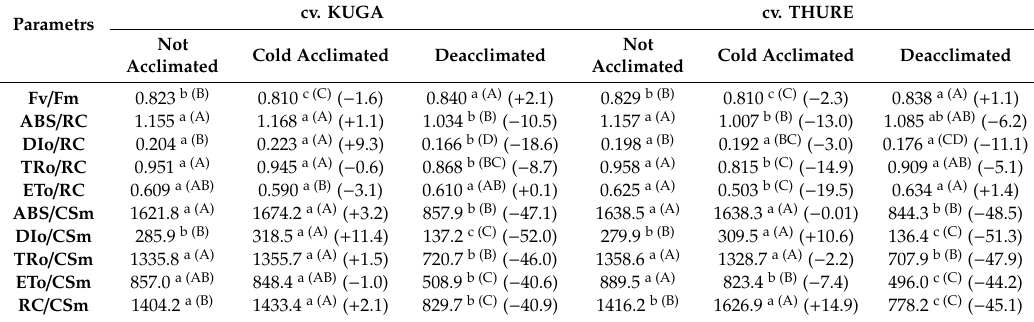
Table 2. Photosystem II e ffi ciency in the leaves of the not acclimated, cold acclimated, and deacclimated oilseed rape cv. Kuga and cv. Thure. Mean values marked with the same letters (a; b; c; d; A; B; C; D—statistical di ff erences) did not di ff er significantly at p ≤ 0.05 according to Duncan’s test, n =